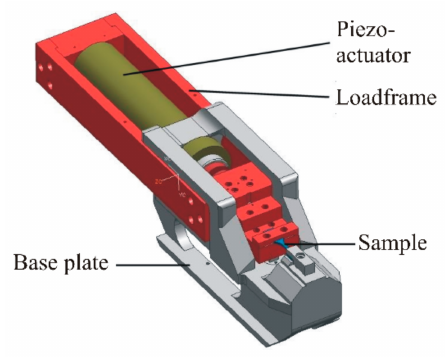
Figure 2. Functional representation of the miniature testing machine [14].